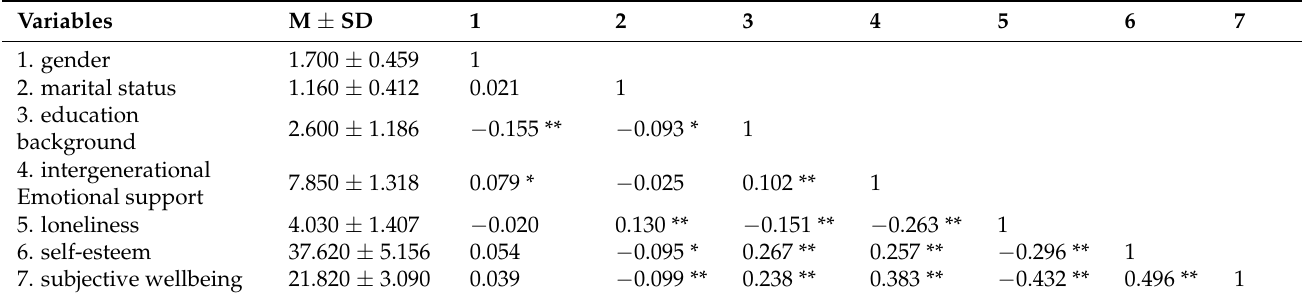
Table 2. Descriptive statistics and correlations among the key variables ( n =728).